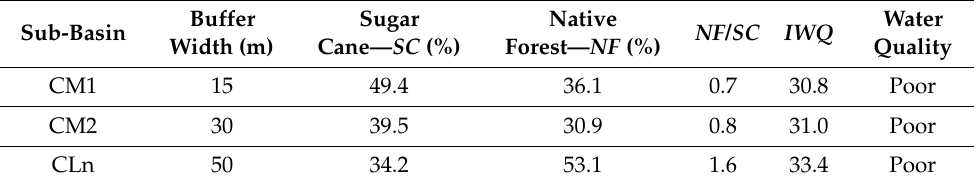
Table 4. Water quality index ( IWQ ) and potentially related environmental variables.